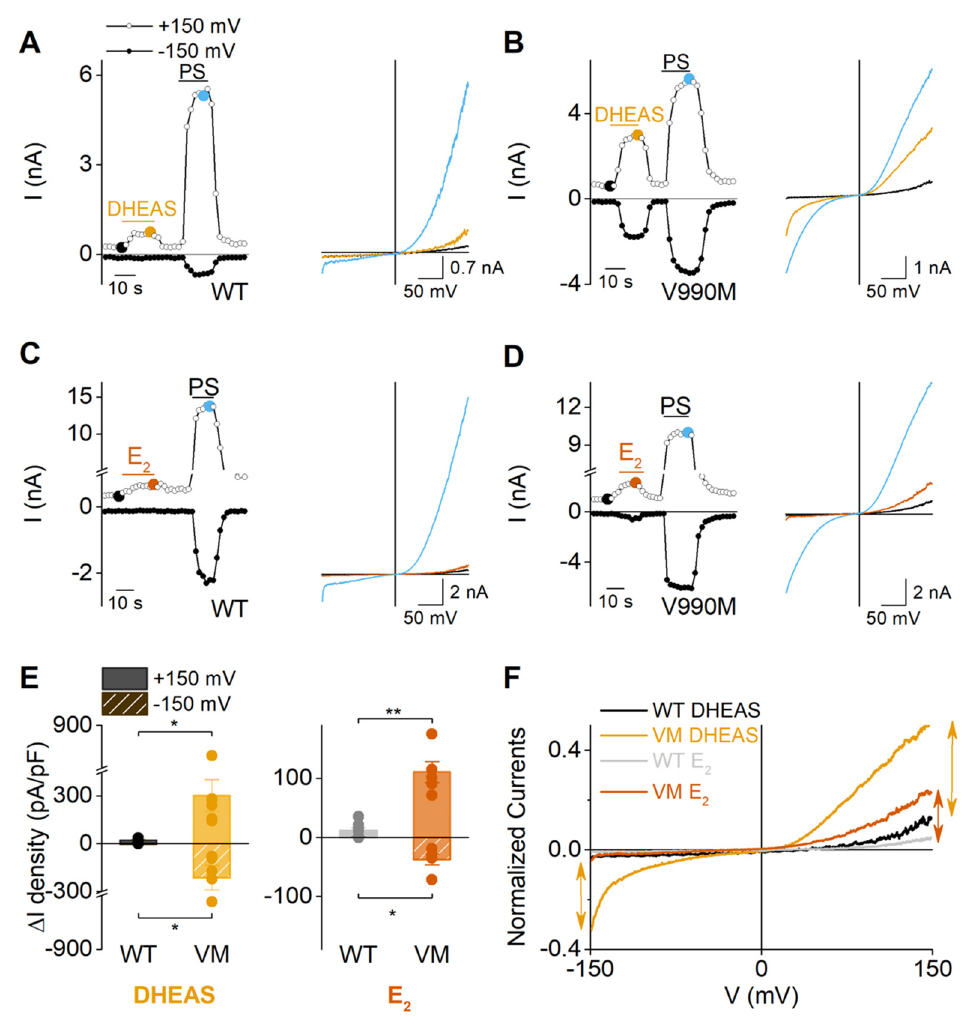
Figure 7. Increased DHEAS and E 2 sensitivity of the V990M variant compared to WT. ( A , B ) Time course of patch clamp experiments on WT or V990M transfected HEK cells, respectively, upon application of 100 µ M DHEAS followed by 40 µ M PS and the corresponding I-V curve of the indicated points. ( C , D ) Time course of patch clamp experiments on WT or V990M transfected HEK293T cells, respectively, upon application of 100 µ M E 2 followed by 40 µ M PS and the corresponding I-V curve of the indicated points. ( E ) ∆ I densities in WT or V990M transfected cells after DHEAS (n = 5) or E 2 (n ≥ 5) application at − 150 and +150 mV. Data are represented as mean ± SEM. Statistical analysis using a two-sample t -test or Mann–Whitney test. p < 0.05 *, p < 0.01 **, p -values for DHEAS: ± 150 mV: p = 0.0122; E 2 : +150 mV: p = 0.0038, − 150 mV: p = 0.0125. ( F ) IV-curves normalized to the maximal response at +150 mV for each cell. Arrows illustrate the amplitude increases between WT and V990M during DHEAS (yellow) or E 2 (red) treatment.